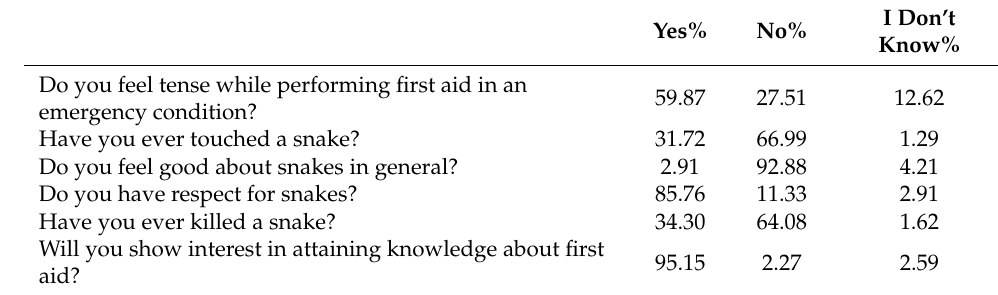
Table 6. Participants’ attitude towards snakebite first-aid management.